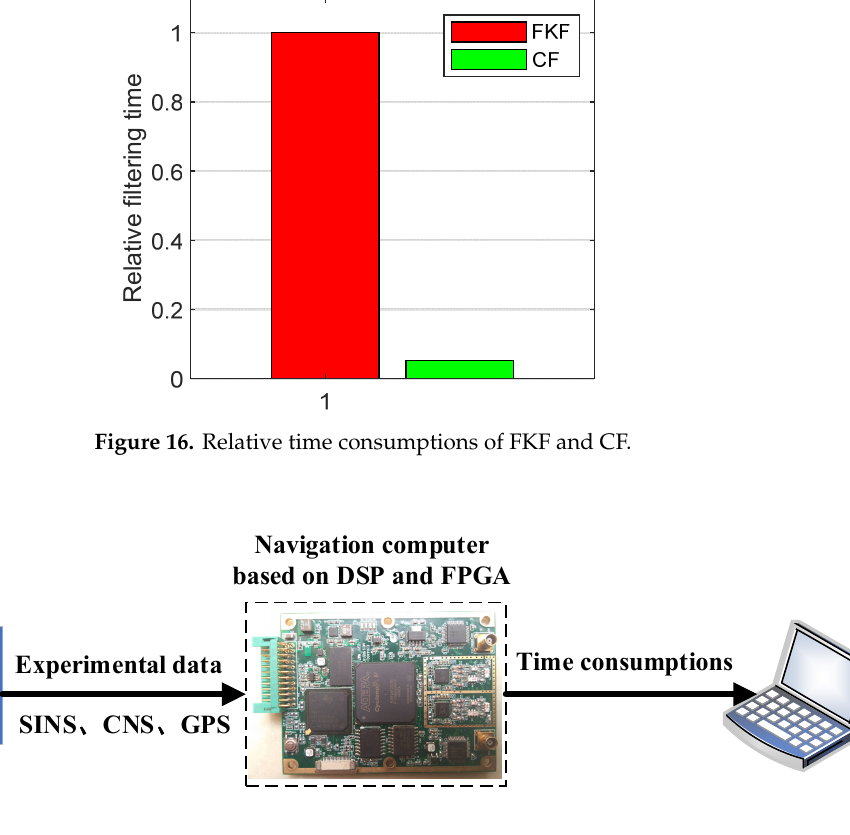
Figure 17. Data processing architecture based on DSP and FPGA chips for real-time system experiment.